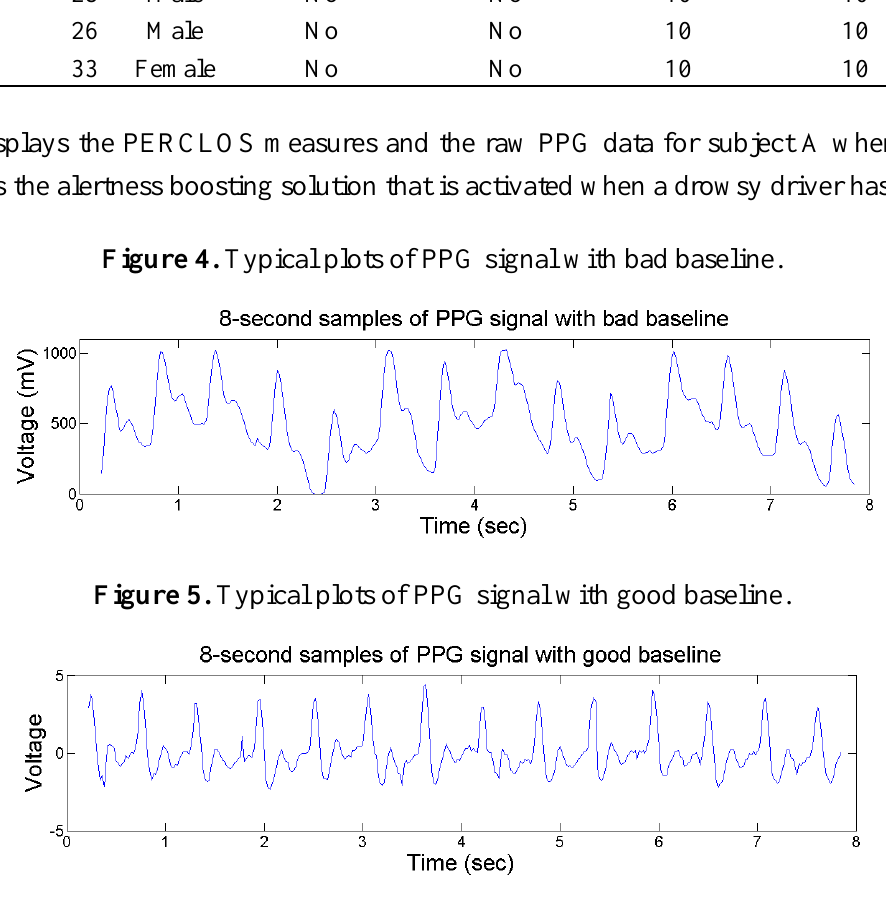
Figure 6. Screenshot of a smartphone that shows the measurement of the PERCLOS, the display of raw PPG data, and the estimation of the driver‟s level of